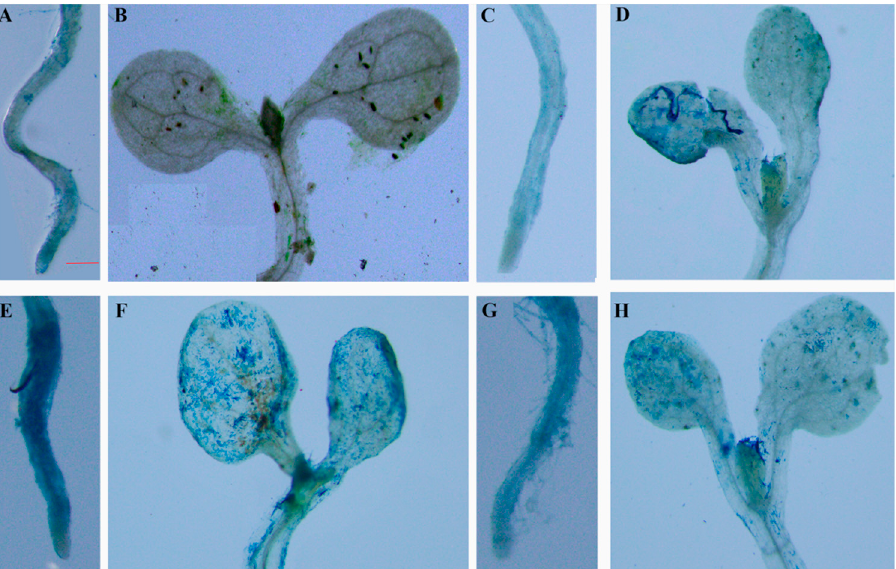
Figure 5. GUS analysis of the roots and leaves of transgenic Arabidopsis harboring P Lm-6-SFT ::GUS under different conditions. Ten-day-old T3 seedlings were used for GUS staining. ( A ), ( B ) control. ( C ), ( D ) 200 mM NaCl for 2 d. ( E ), ( F ) 90 µ E · m –2 · s –1 illumination. ( G ), ( H ) 5 µ M ABA. The red scale bar represents 0.2 mm.